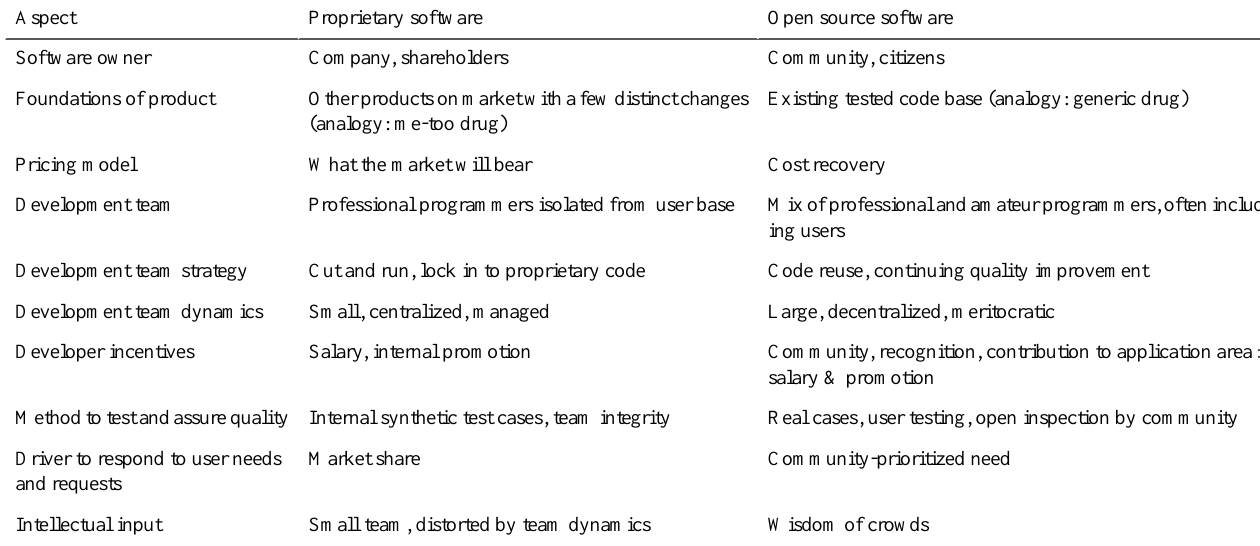
Table 1. Comparison of proprietary and open source software development